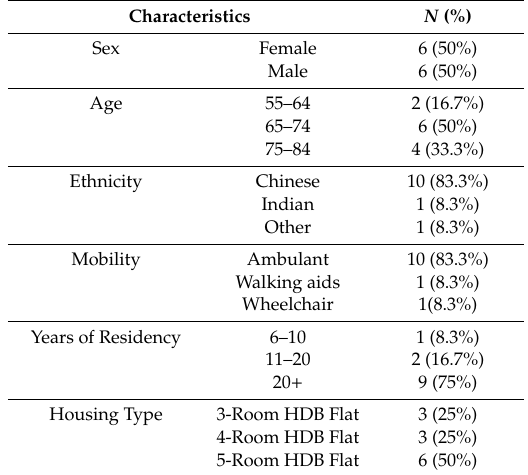
Table 1. Characteristics of the study participants; N =